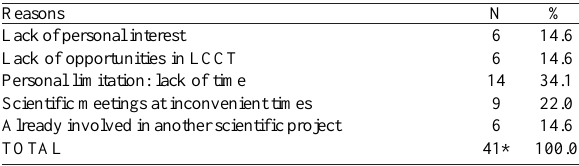
Table 4. Reasons given not to participate in a scientific project linked to LCCT.